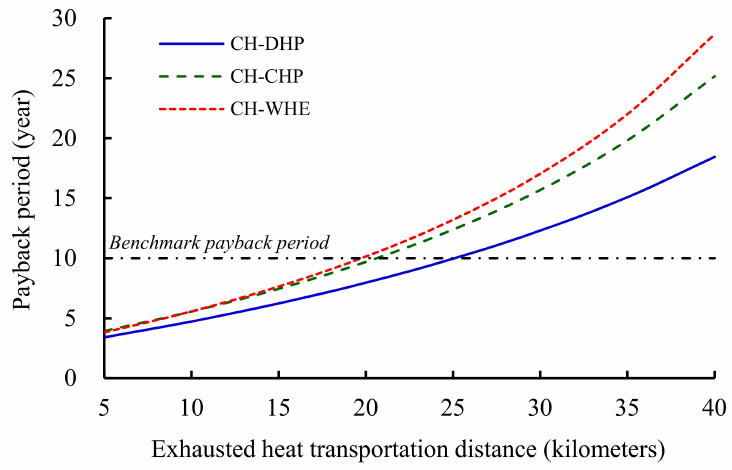
Figure 10. Impacts of exhausted heat transportation distance on payback